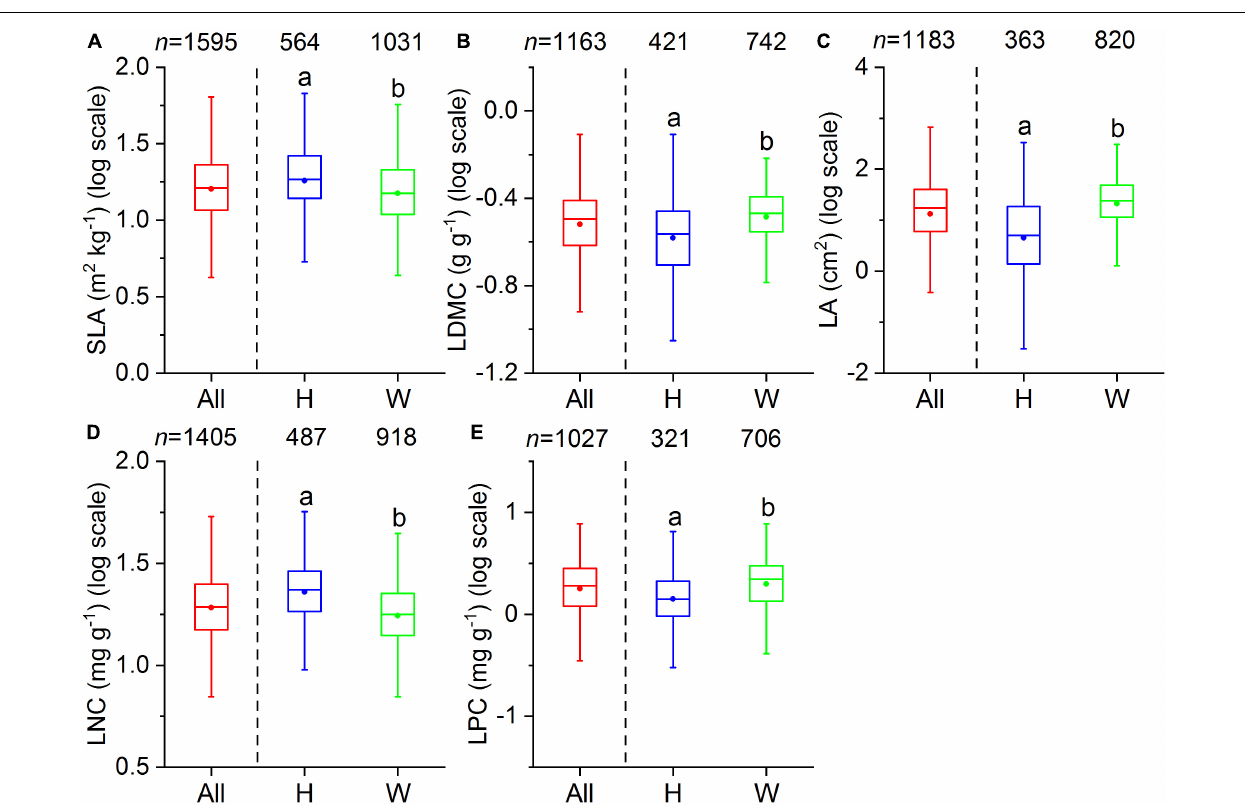
Frontiers in Plant Science |